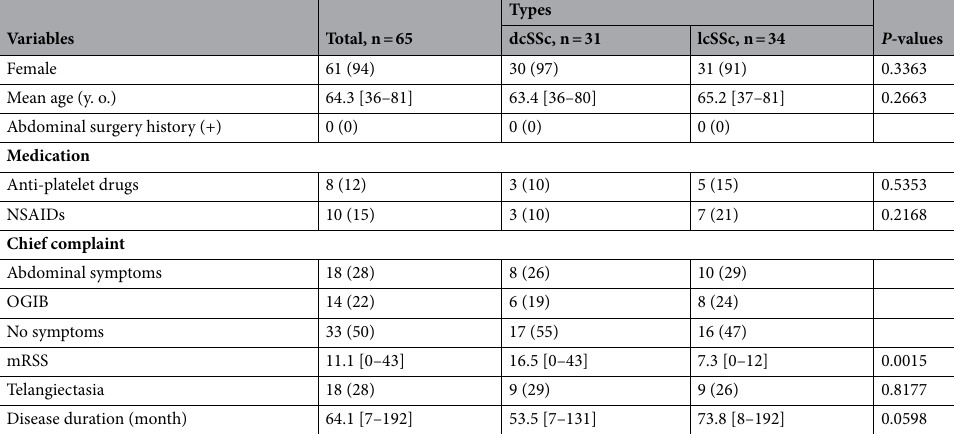
Variables Total, n =